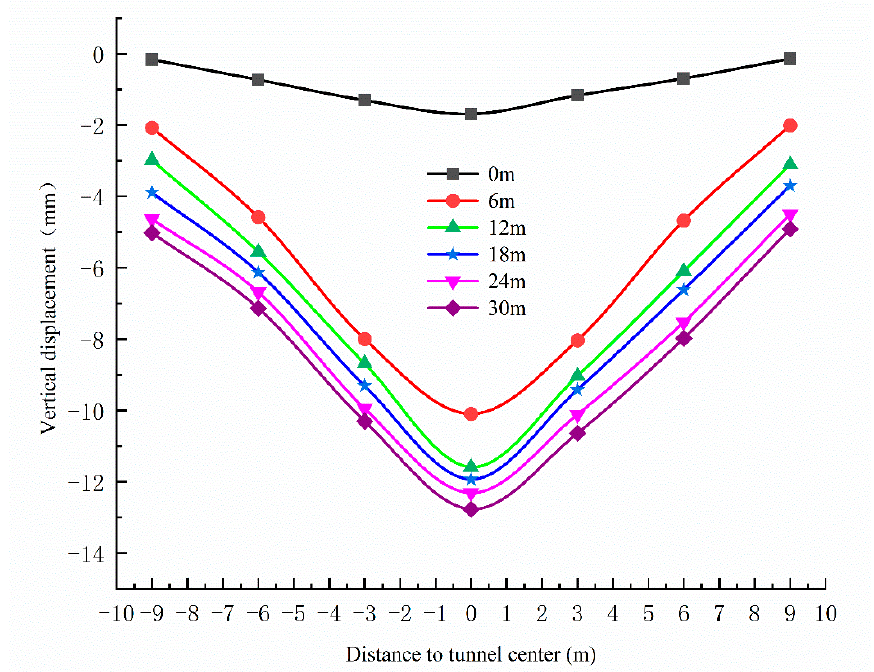
Figure 6. Transverse vertical displacement of the ground surface.